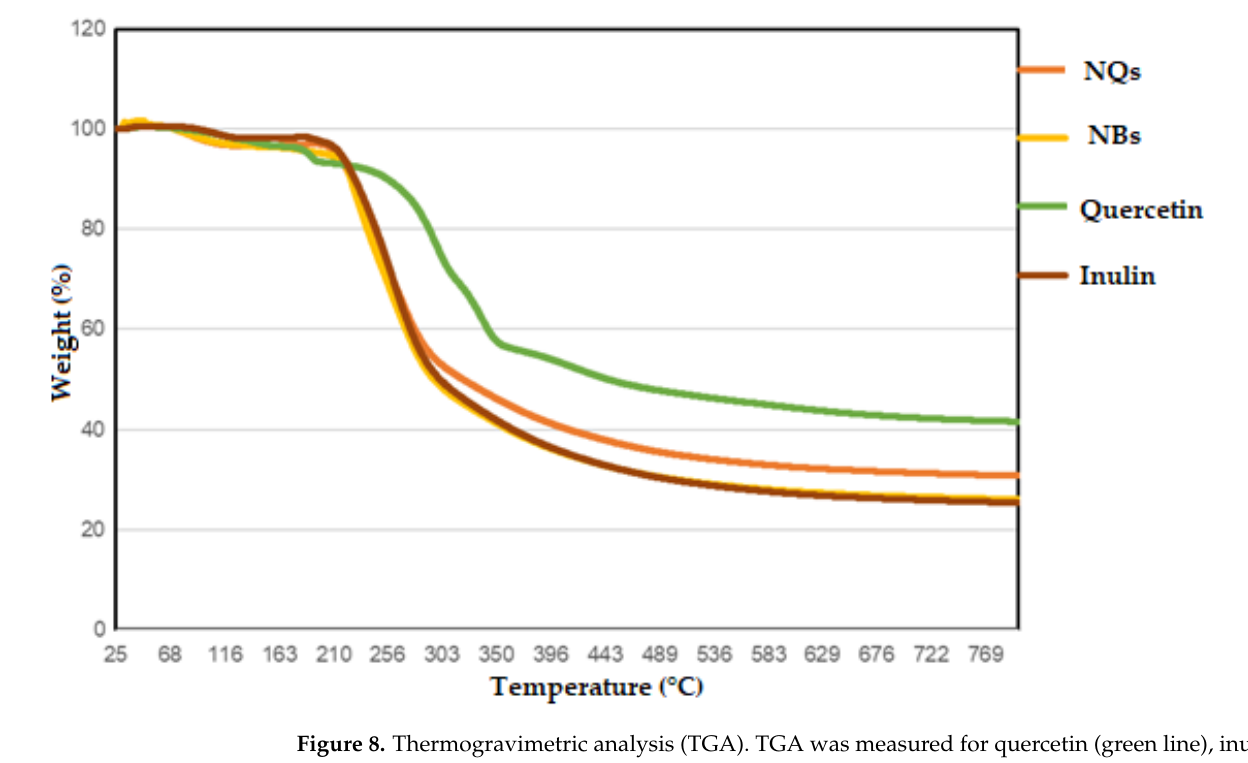
Figure 8. Thermogravimetric analysis (TGA). TGA was measured for quercetin (green line), inulin (brown line), inulin nanoparticles loaded with quercetin (NQs) (orange line) and inulin non-charged nanoparticles (NBs) (yellow line). Table 4. TGA data, % of weight loss vs. increment of temperature in loaded and unloaded nanoparti- cles, inulin and